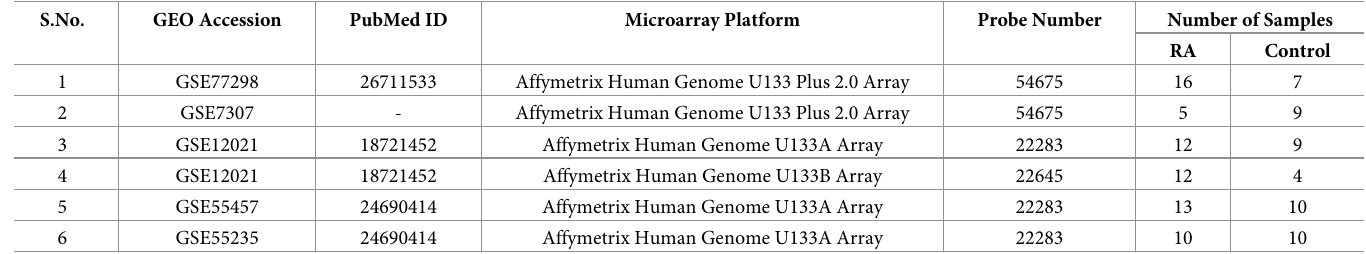
Table 1. Details of microarray datasets used in this study.